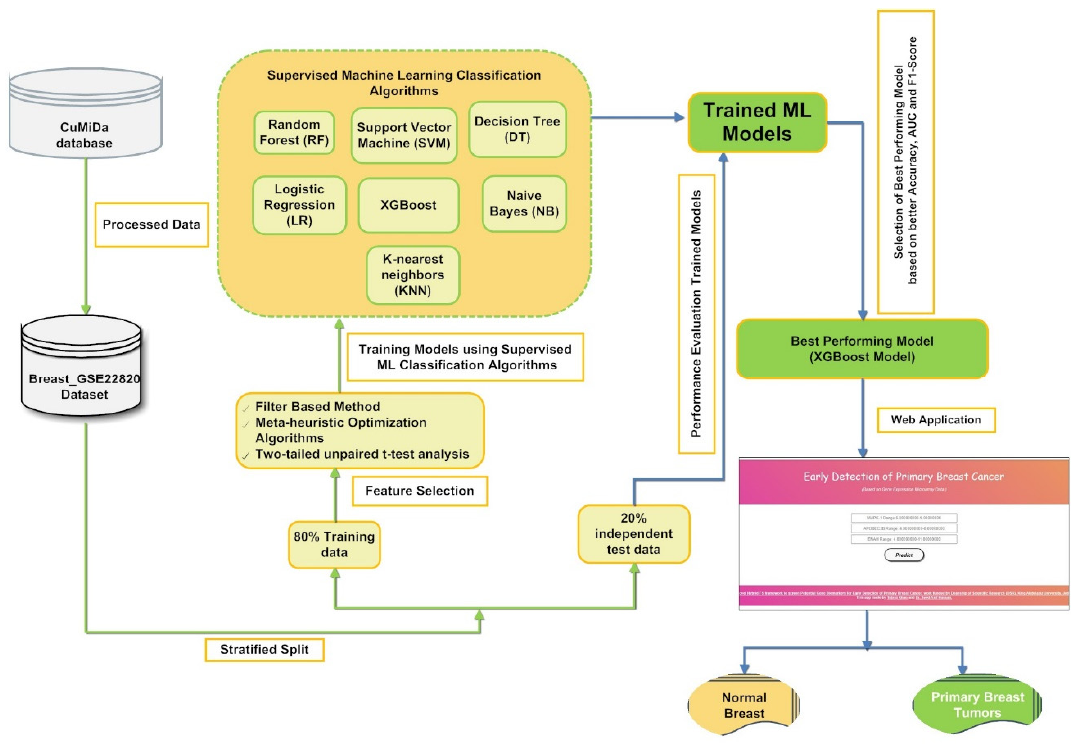
Figure 1. A pictorial representation of the proposed framework for screening a stable set of gene biomarkers from gene microarray data to build a supervised classifier-based application for classifying primary breast cancer samples from normal breast samples.